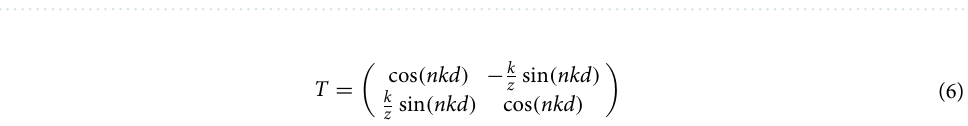
Figure 5. The reflection loss S 11 and transmission coefficient S 21 of the frequency reconfigurable metamaterial at different